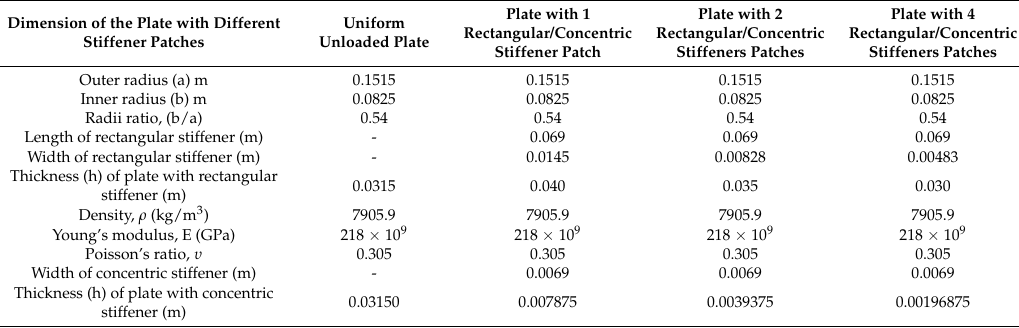
Figure 2. Plate with different parabolic varying thickness variations. Table 1. The specifications and the material properties of an annular circular plate with different attachment of rectangular and concentric stiffener patches.